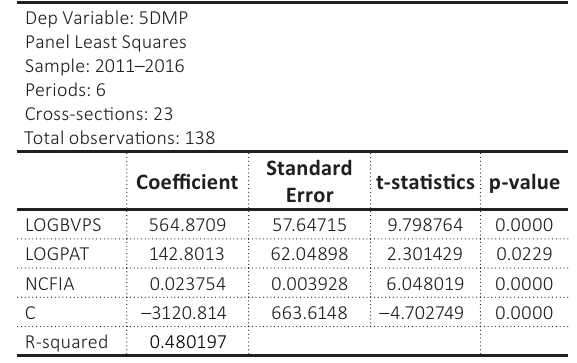
Table 5. Regression, pre-Ind AS (2011–2016)